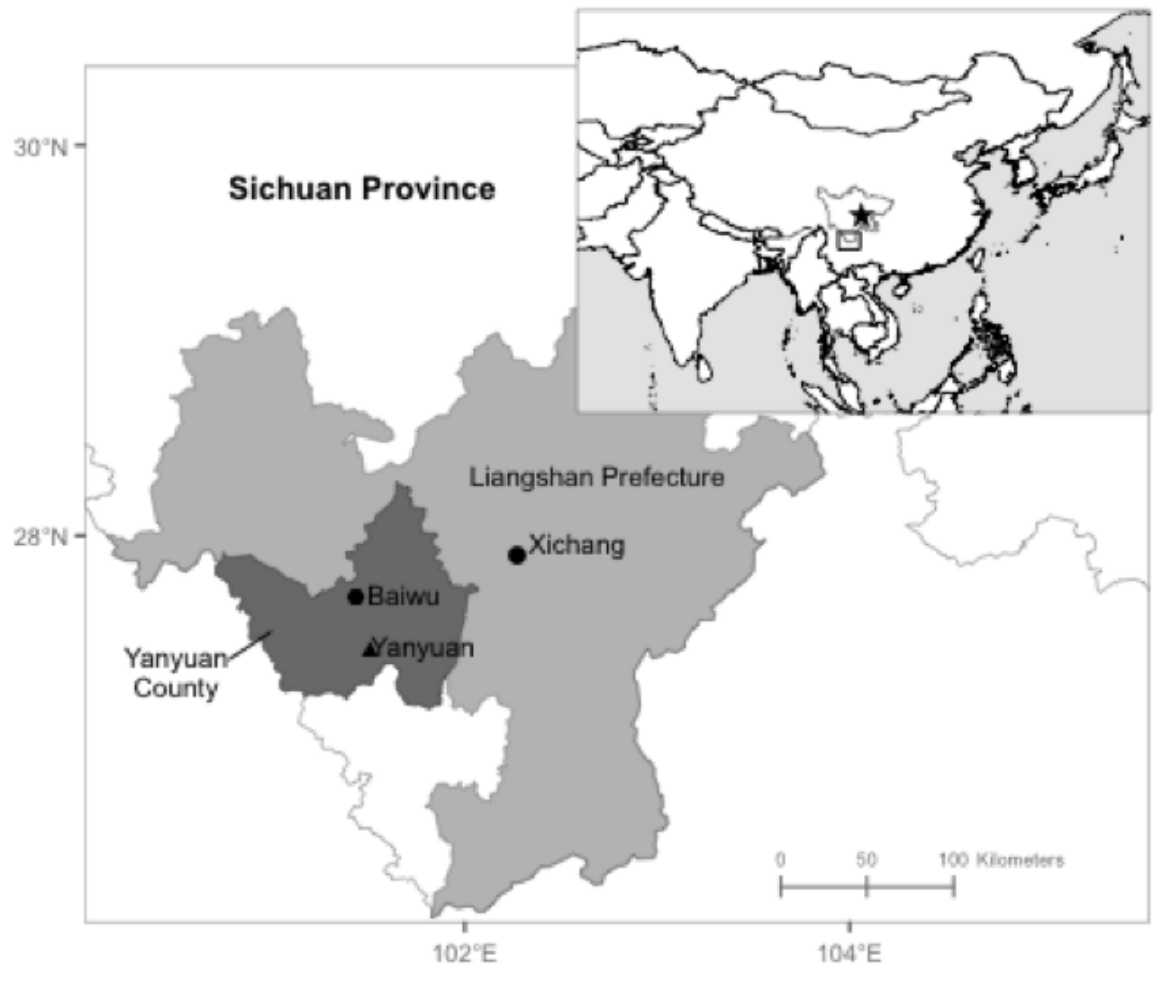
Fig. 1. Location of the Baiwu Valley in Yanyuan County, Liangshan Autonomous Prefecture, Sichuan